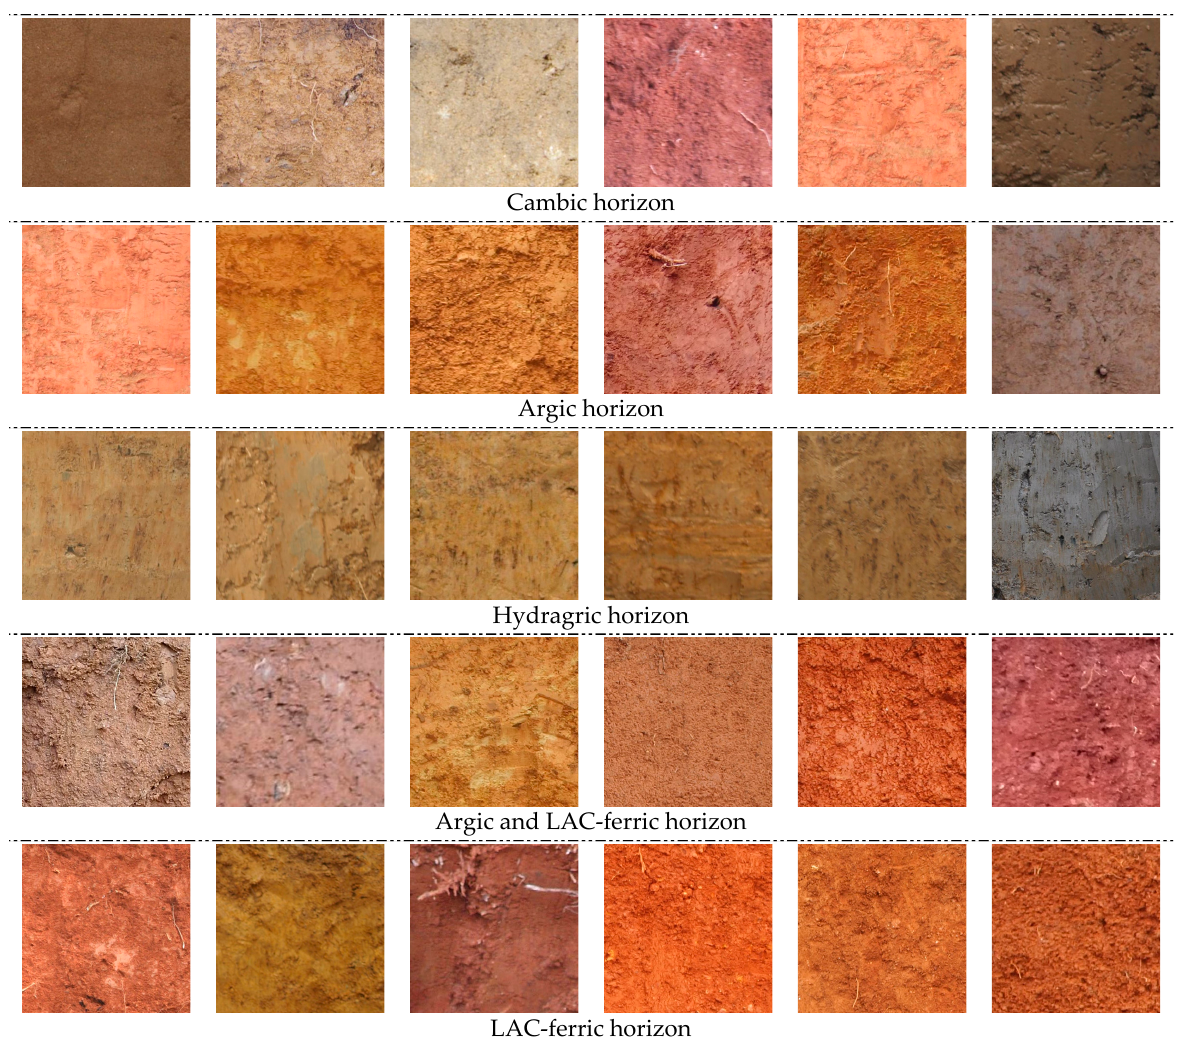
Figure 6. Example images of soil diagnostic horizons (For demonstration purposes only, not as model input data). Some images have out-of-focus or color imbalance, which is intentional by adjusting the camera parameters during field survey, as this will reinforce the robustness of the